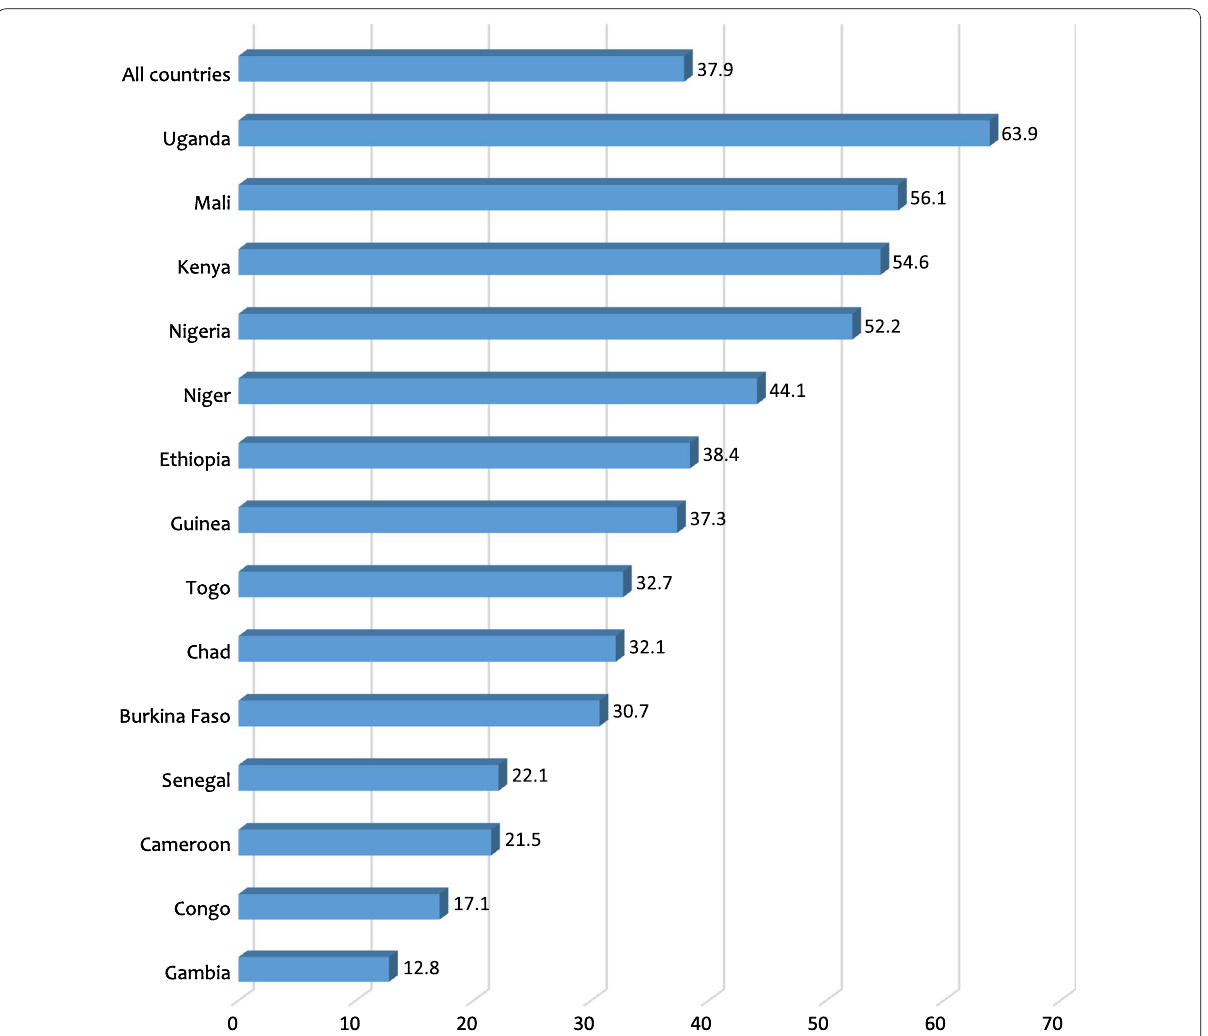
Fig. 1 Prevalence of awareness of obstetric fistula among women in sub‑Saharan